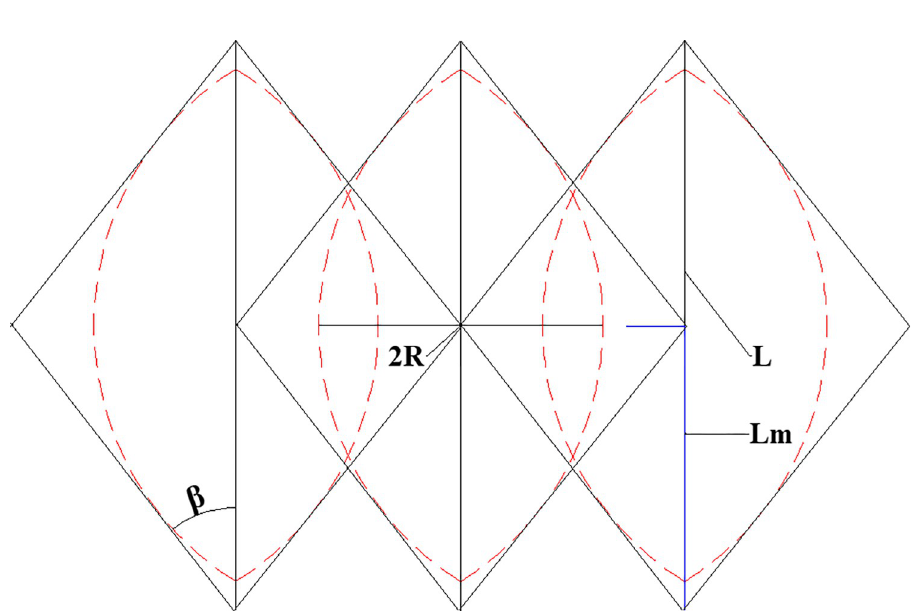
Fig 8. Anchor support reinforced arch